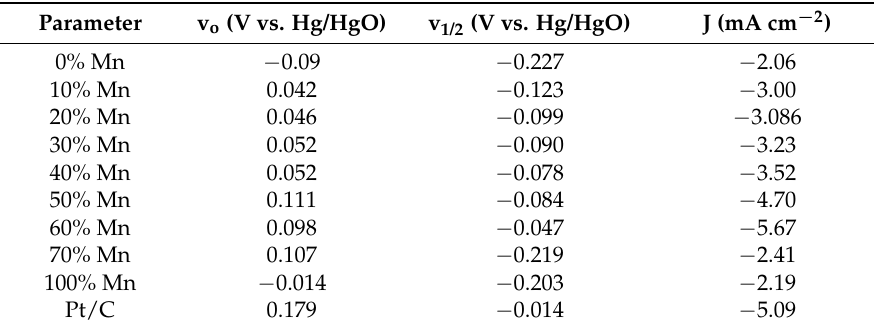
Table 1. Initial potential (v o ), half-wave potential (v 1/2 ) and limiting current density (j) of commercial Pt/C and Ag 4 Bi 2 O 5 with different contents of MnO 2